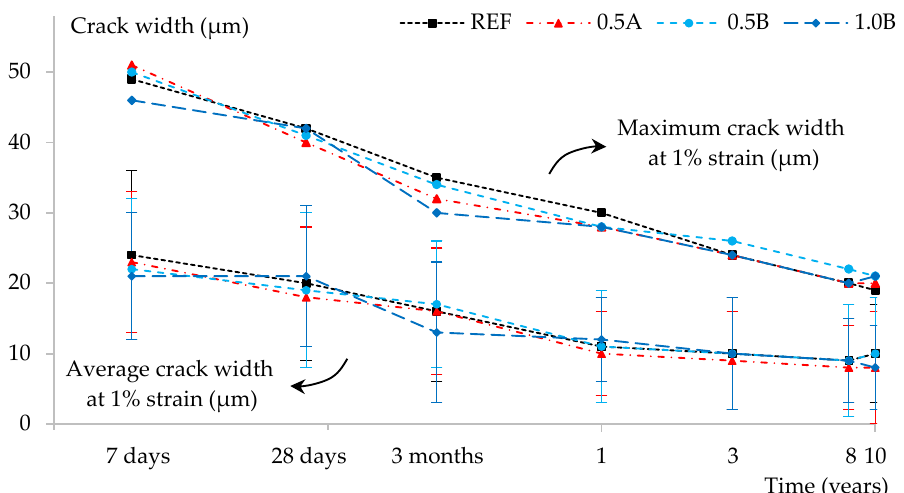
Figure 1. The observed mean crack width at 1% strain preloading and the observed maximal crack width at 1% strain (µm).